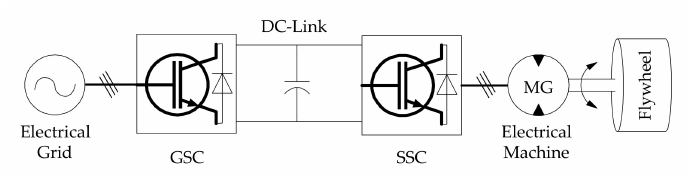
Figure 4. FESS with back-to-back bidirectional power